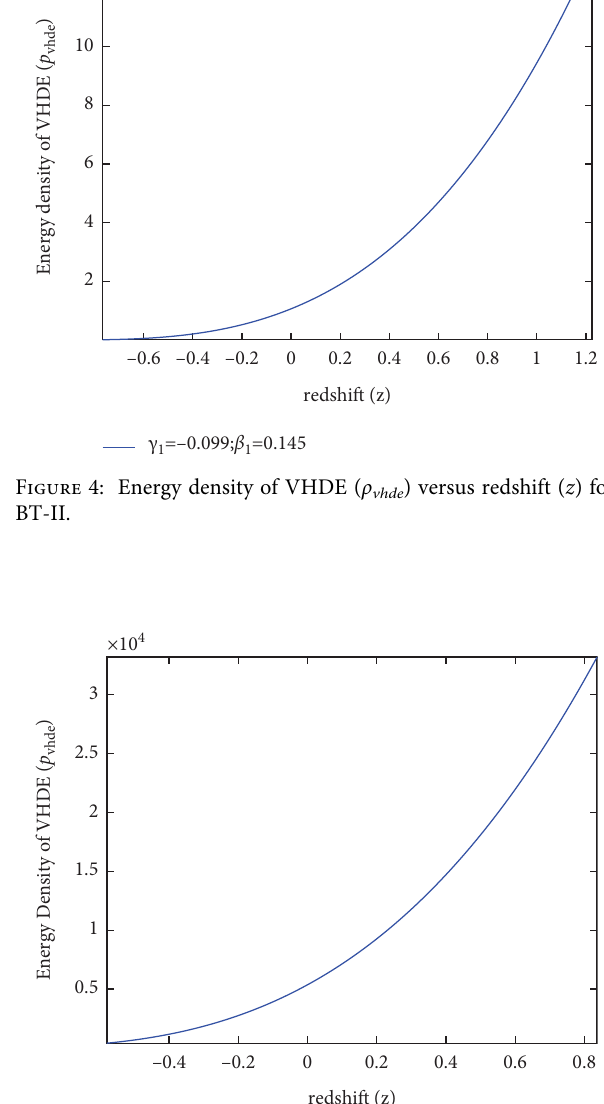
vhde ) versus redshift ( z ) for BT-